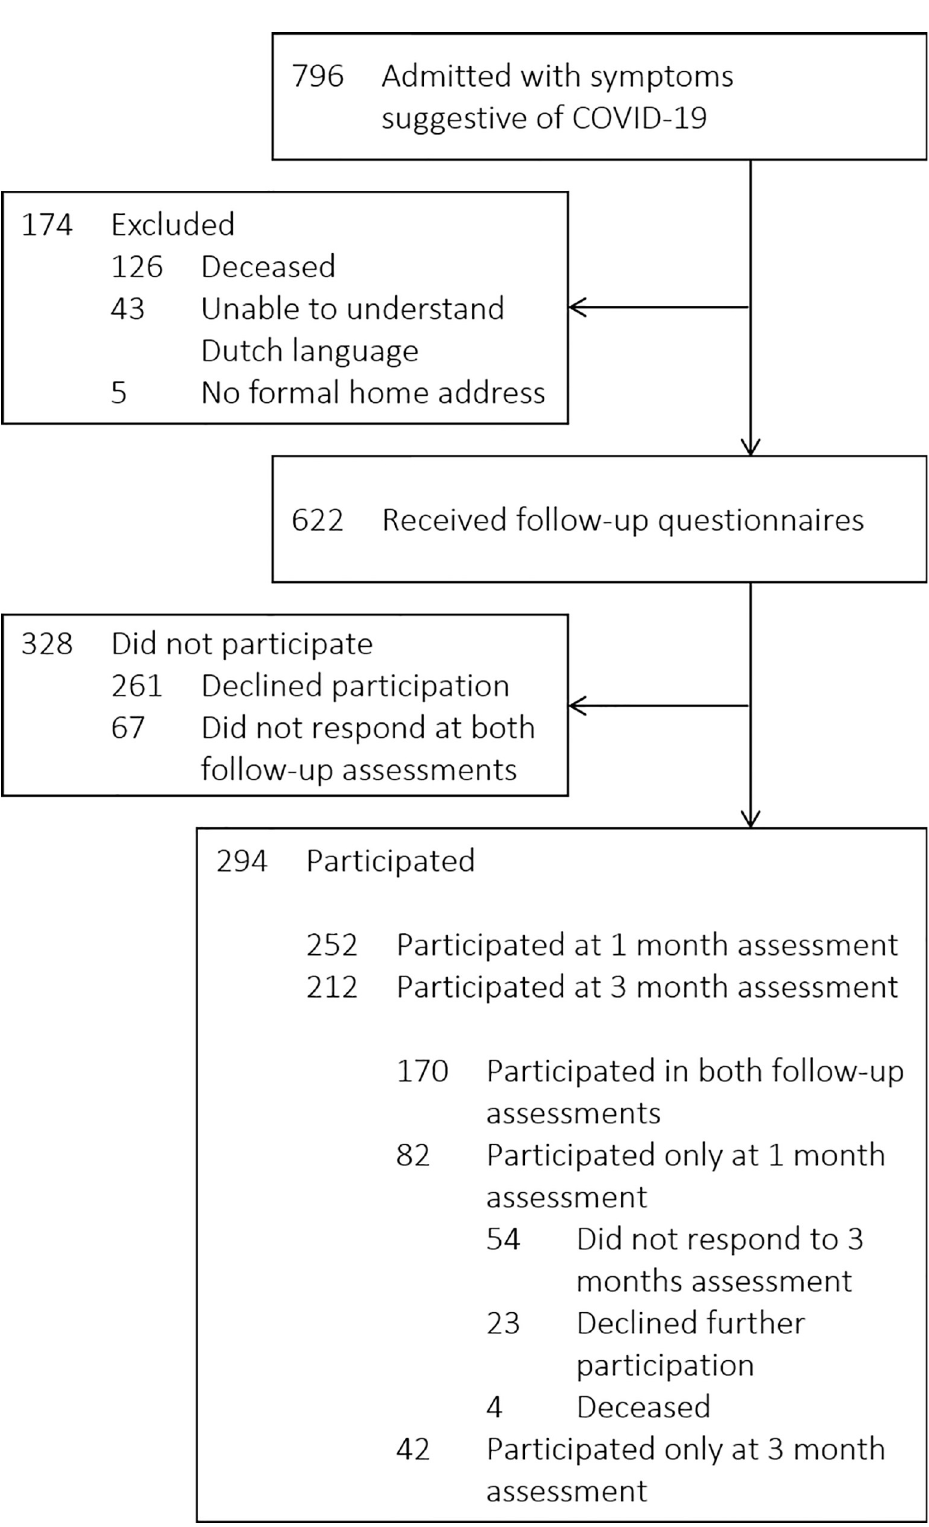
Fig 1. Flow chart of the recruitment, inclusion, and follow-up of study participants.